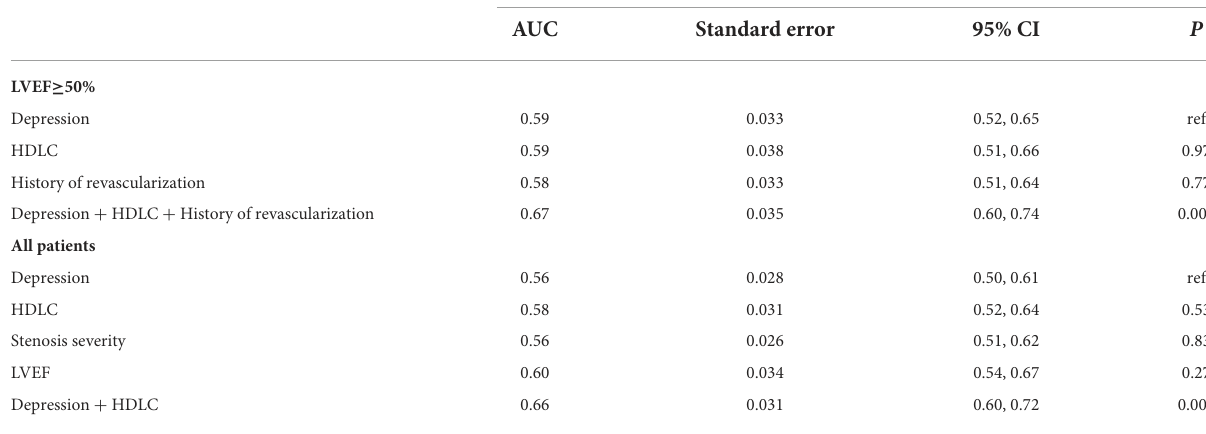
TABLE 4 Comparisons of predictive values for MACE in patients with LVEF ≥ 50% and in the whole